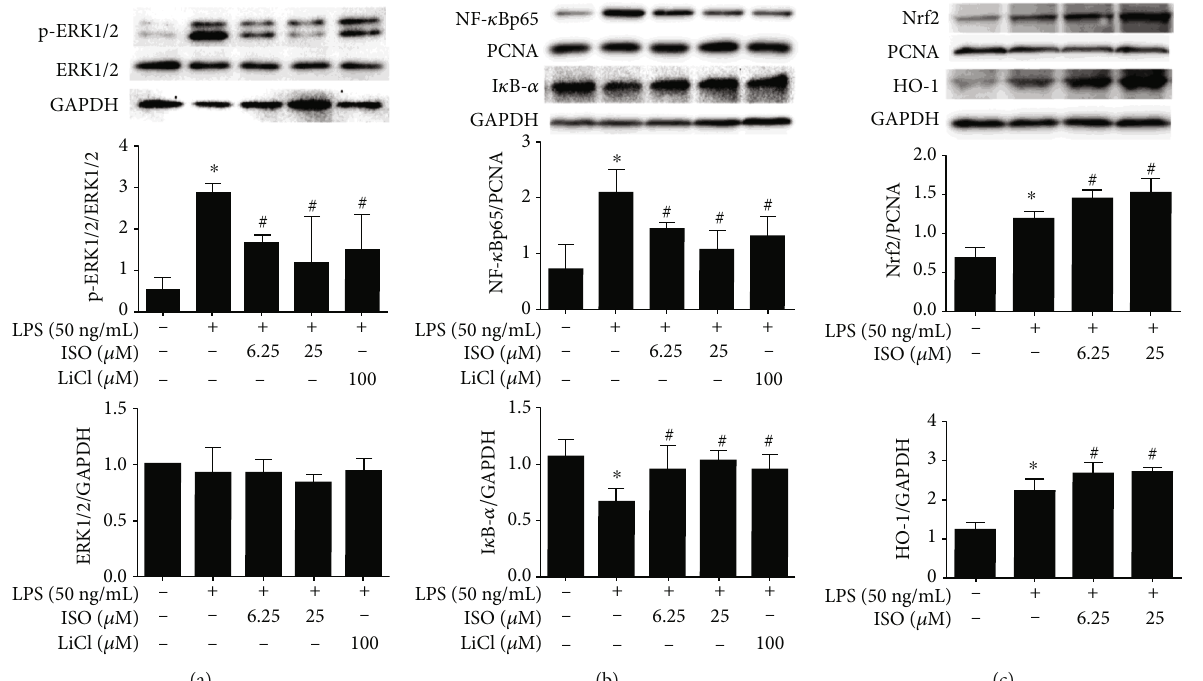
Figure 3: E ff ects of isoorientin on the activation of ERK (a), NF- κ B (b), and Nrf2/HO-1 (c) in LPS-activated RAW264.7 cells. RAW264.7 cells were treated with isoorientin (6.25 and 25 μ M) or LiCl (100 μ M) for 1h with or without stimulation of LPS (0 and 50ng/mL). After the indicated time of LPS stimulation, the cells were collected for immunoblotting of p-ERK1/2 and ERK1/2 (15 min), Nucl-NF-kBp65 (1 h), cyto-I κ B- α (1 h), Nucl-Nrf2 (18 h), and cyto-HO-1 (18 h). The data were expressed as mean ± SEM ( n = 3 , 3 independent experiments). Statistical analysis was done using ANOVA. ∗ P < 0 : 05 versus the control group, # P < 0 : 05 versus the LPS